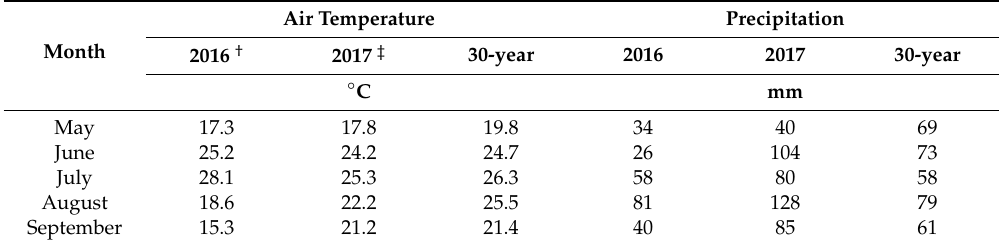
Table 1. Average monthly air temperature and total rainfall near Canyon, TX for 2016–2017. Thirty year averages (30-year) were calculated from data collected from the National Weather Service Forecast O ffi ce from